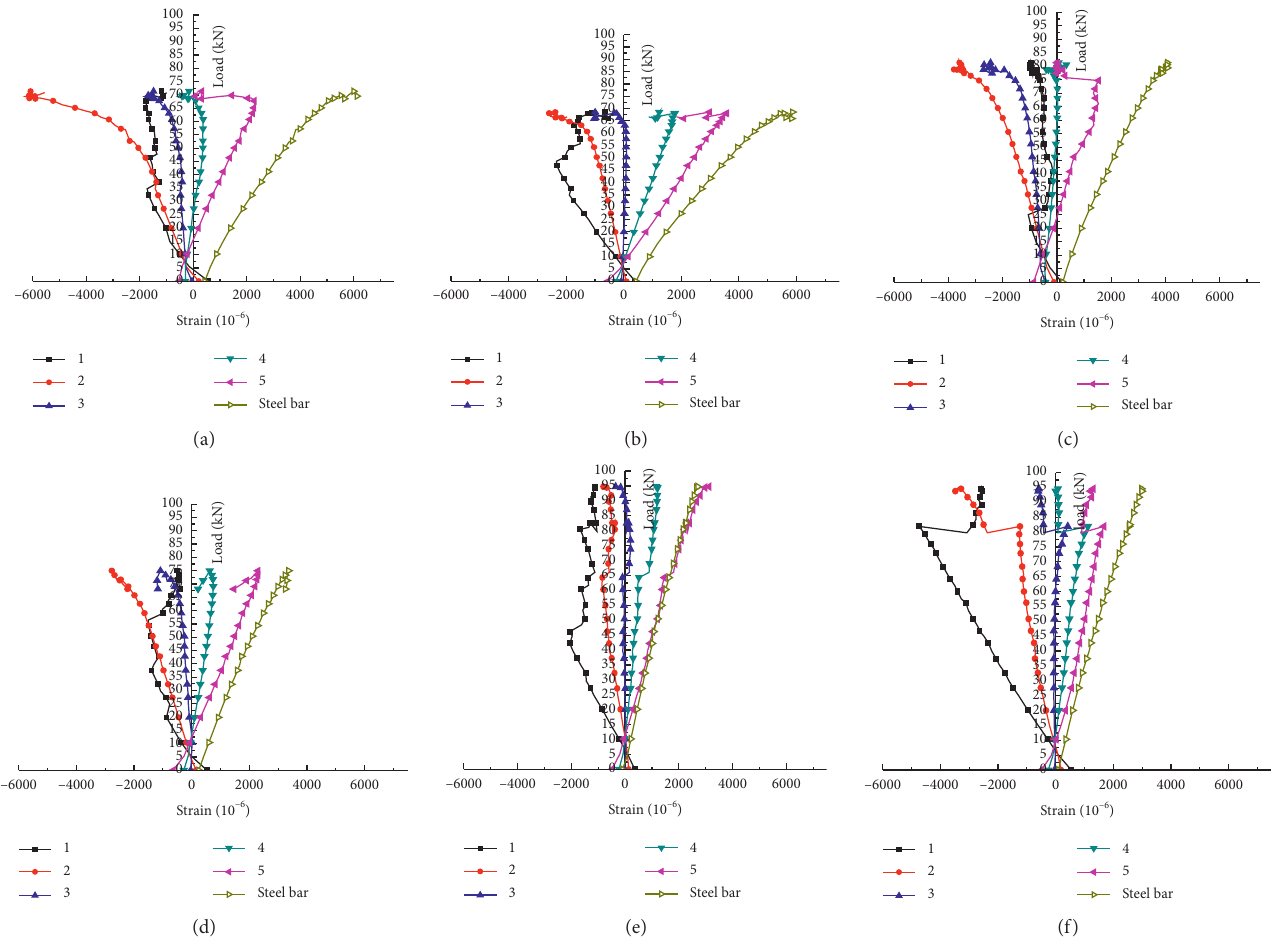
Figure 11: Load-strain curves of beams with different numbers of steel bars. (a) Load-strain curves of the L curves of the L A4(2) right span. (c) Load-strain curves of the L A5(2) left span. (d) Load-strain curves of the L A5(2) right span. (e) Load-strain curves of the L A6(1) left span. (f) Load-strain curves of the L A6(1) right